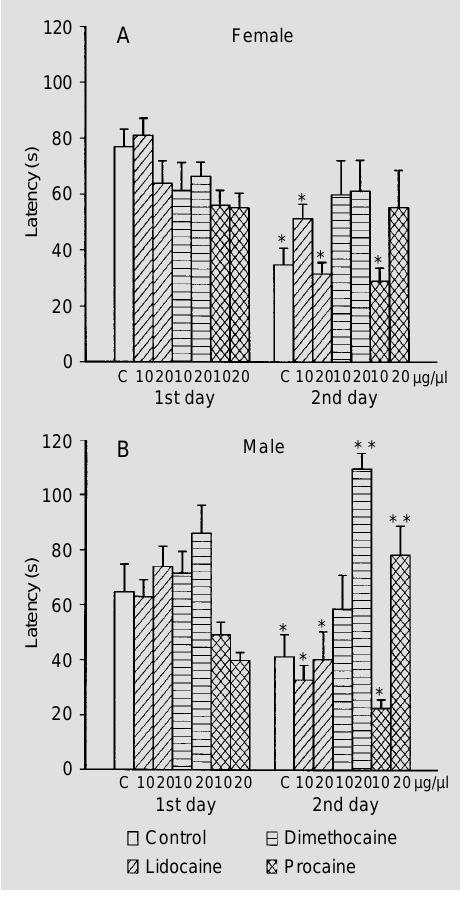
Figure 1 - Effects of intracere- broventricular administration of lidocaine, dimethocaine and procaine on the latency of fe- male (A) and male (B) mice to move from the open arm to the enclosed arm of the plus-maze. Data are reported as means ± SEM of 10 mice. *P £ 0.05 com- pared to the 1st day (Student t- test). **P £ 0.05 compared to the control group (Newman-Keuls test).